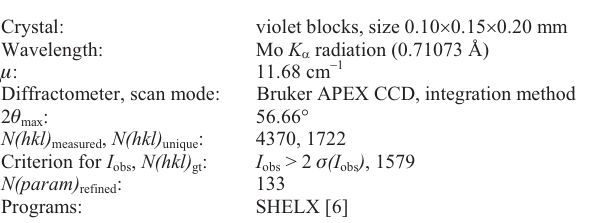
Table 1. Data collection and handling.